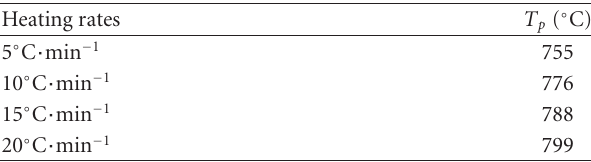
Table 3: Onset temperature for each heating rate